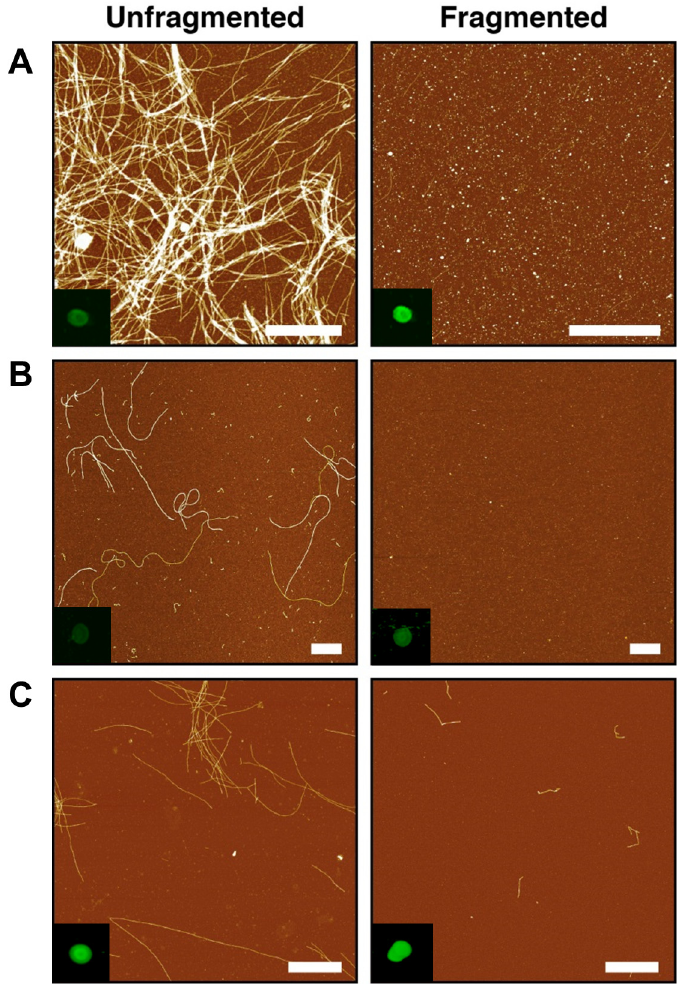
fibril LOC antibody specific to generic epitopes common in amyloid